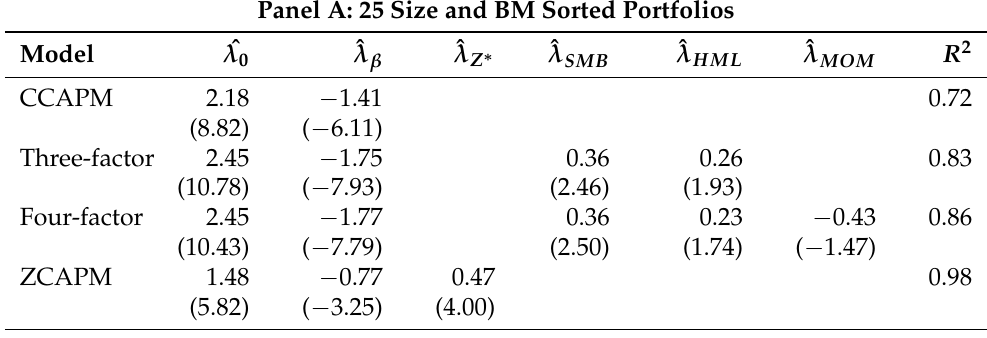
Panel B: 25 Size and Momentum Sorted